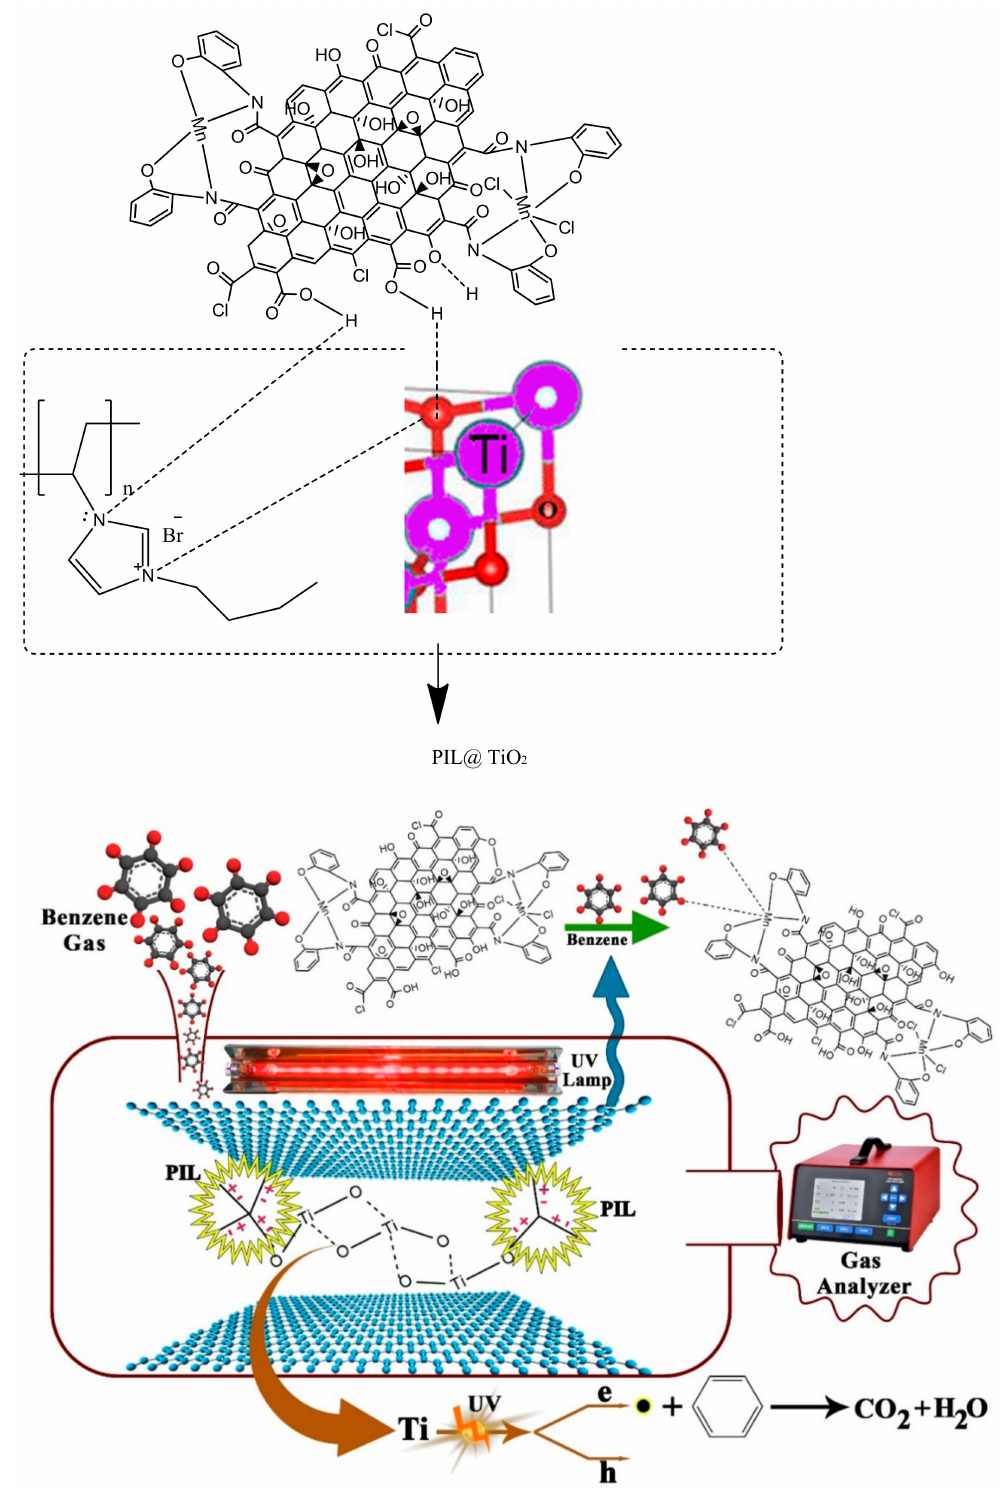
Figure 9. Schematic view of the linking PIL@TiO 2 to m-GO ( top ) and the absorption of benzene during the photocatalytic degradation of benzene ( bottom